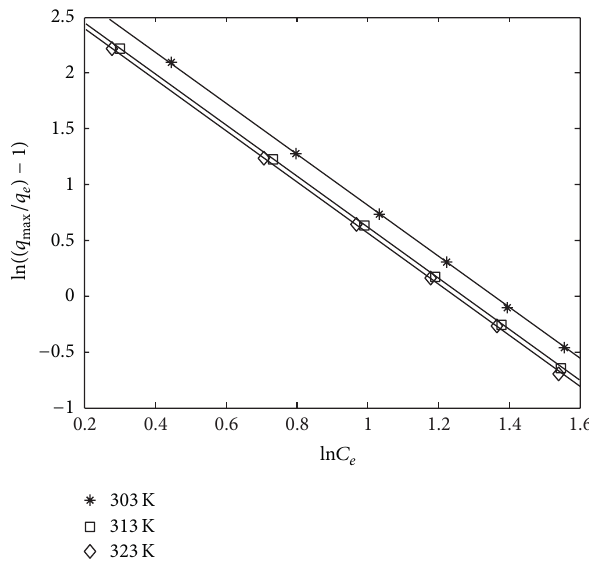
Figure 10: Linearized Tempkin isotherm at different temperatures ( 𝑀 : 0.3 g; pH: 6; agitation rpm: 150).